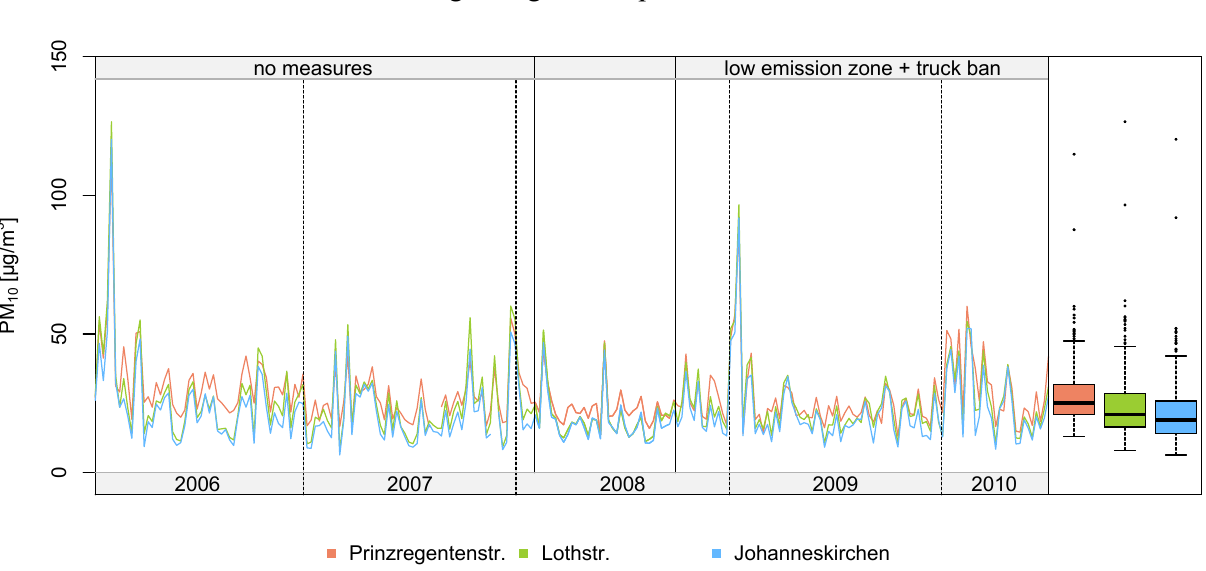
concentrations at three monitoring sites 10 10